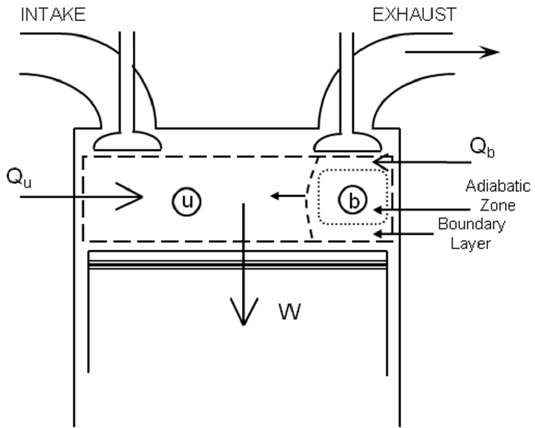
Figure 1. Schematic of the three-zone configuration of the cycle simulation. dashed lines represent control volumes and arrows denote energy transfers and designate two of the zones.